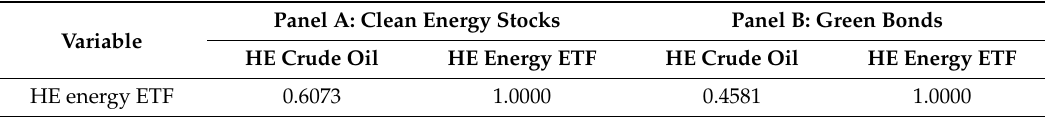
Table 5. Correlation of hedging e ff ectiveness.